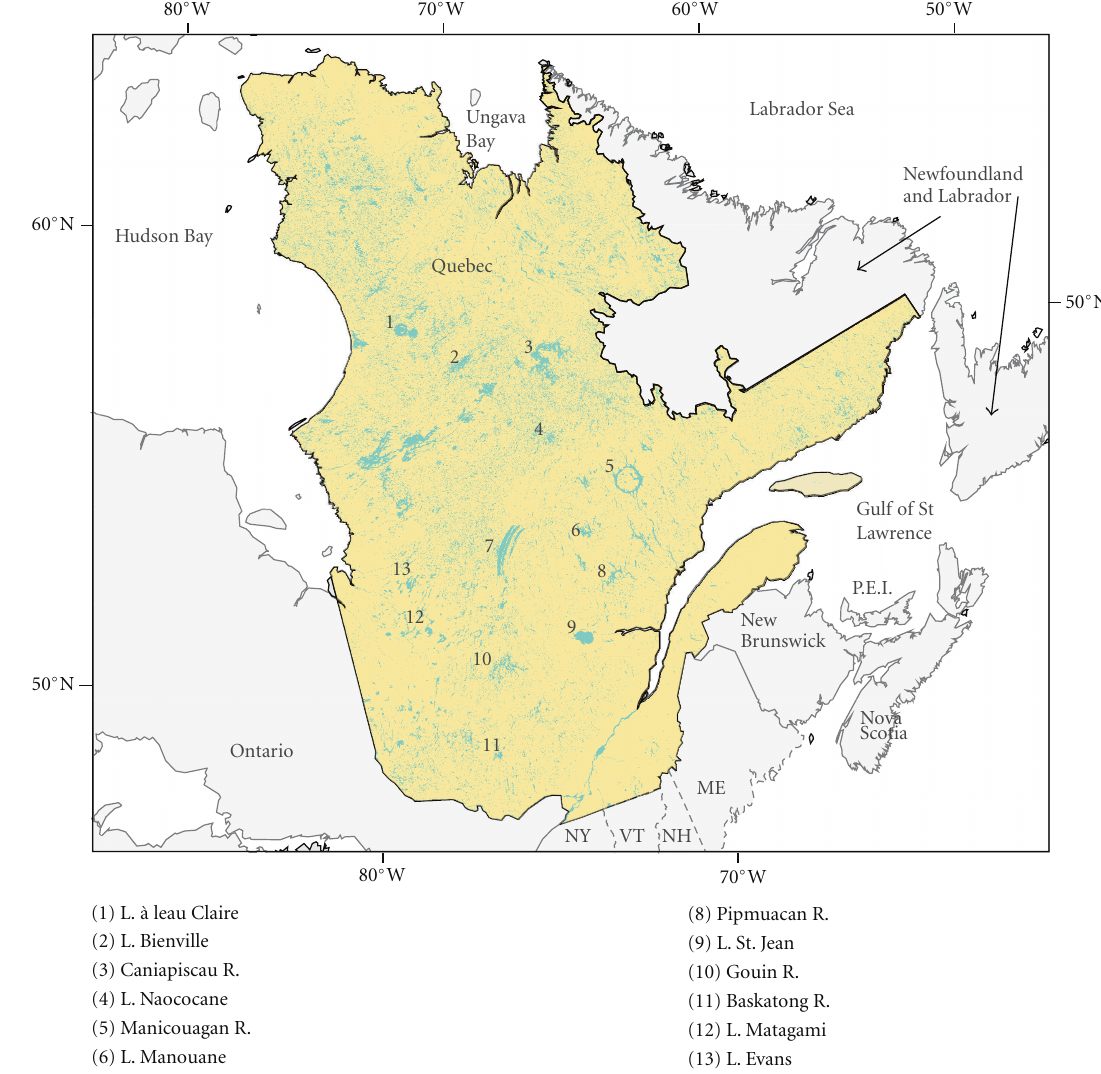
Figure 1: Map of the province of Quebec, Canada, with the specific lakes (L.) and reservoirs (R.) referred to in this paper indicated.